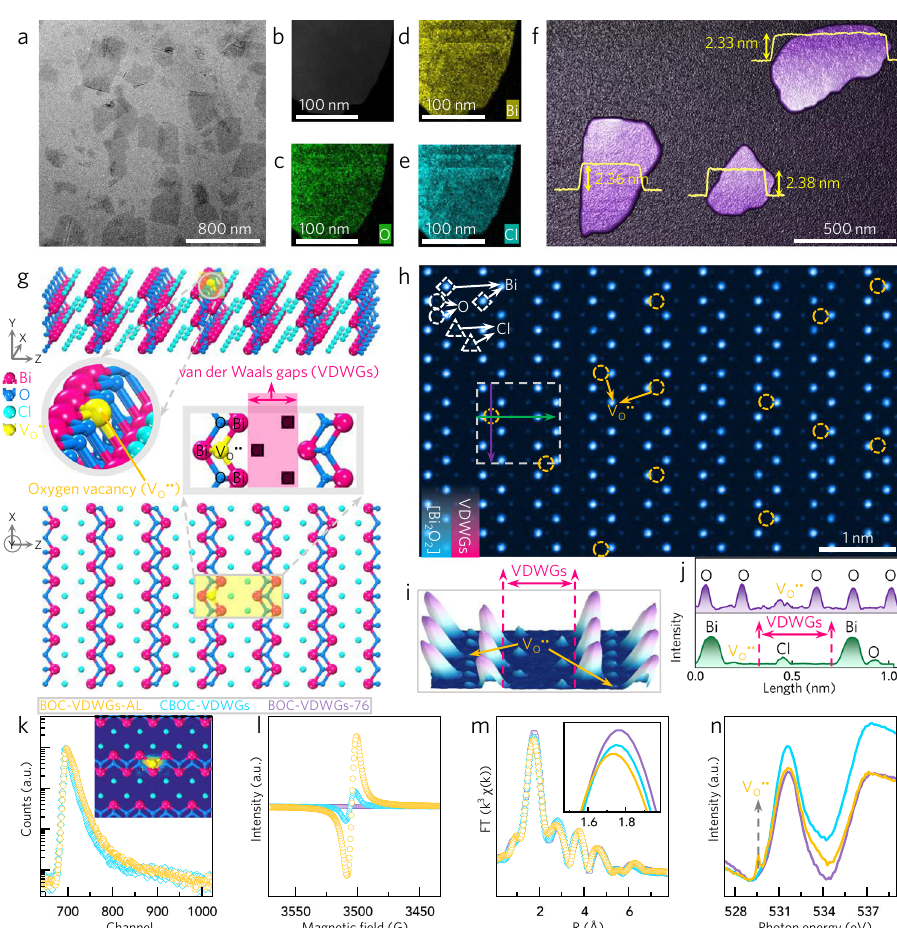
Fig. 1 Characterizations of VDWGs-rich structure of BiOCl atomic layers. a TEM image, b dark- fi led STEM image, c – e elemental mappings, f AFM image, g theoretical crystalline structures, h aberration-corrected HAADF-STEM image, i three-dimensional topographic color-coded intensity image (taken from h ), and j intensity pro fi les (taken along the lines of h ) of BOC-VDWGs-AL. k PAS, l EPR, m Bi L 3 -edge EXAFS, and n O K-edge XANES of BOC-VDWGs-AL, CBOC-VDWGs, and BOC-VDWGs-76. The inset in k is the simulation result of the positron density distribution of VDWG-Bi-V O (cid:129)(cid:129)